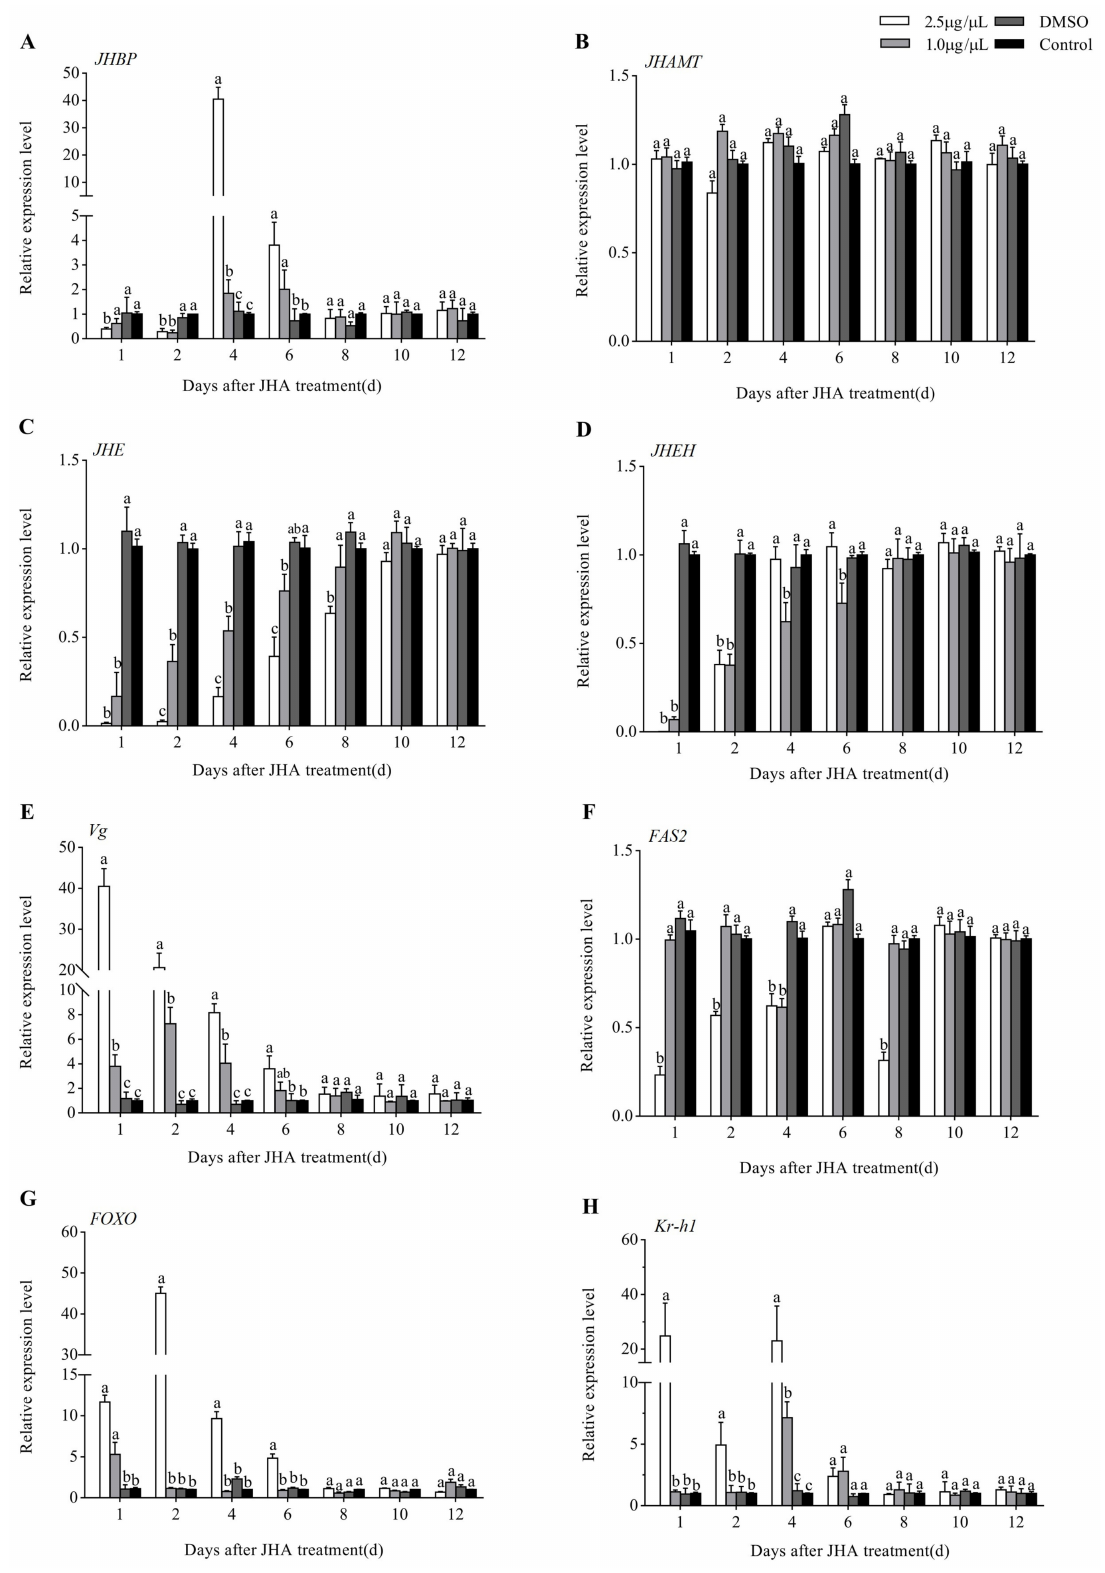
Figure 5. Expression profiles of 8 JH signaling-related genes after JHA application at 3 days post-eclosion. Different letters above the columns indicate significant difference among different treatments at the same time at p < 0.05 (Tukey’s HSD test). ( A ): JHBP ; ( B ): JHAMP ; ( C ): JHE ; ( D ): JHEH ; ( E ): Vg ; ( F ): FAS2 ; ( G ): FOXO ; ( H ): Kr-h1